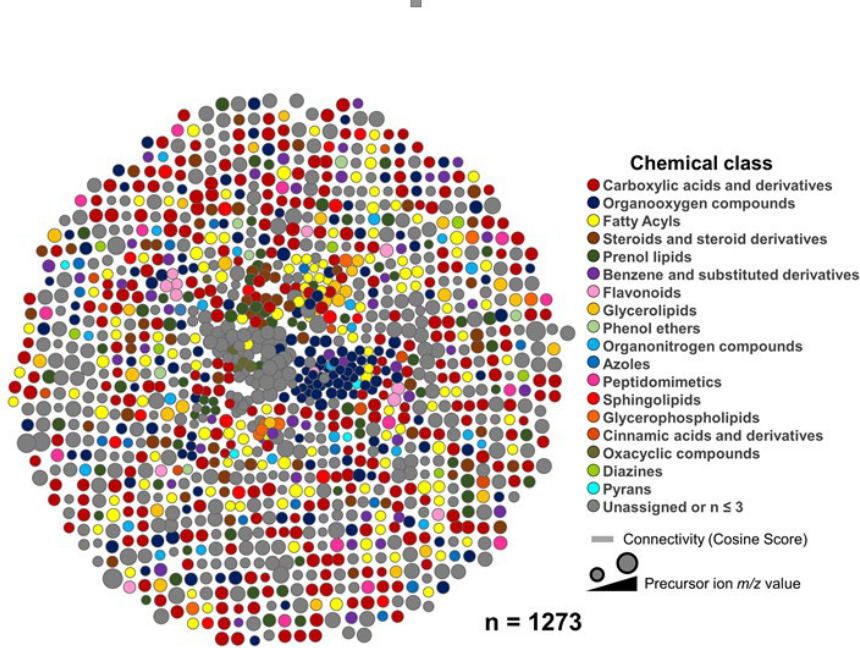
Figure 3. Eggplant metabolite molecular network. Chemical classes (Classyfire ontology, version 1.0 (http://classyfire.wishartlab.com, accessed on 10 August 2022) are assigned to the metabolites by the CANOPUS tool (implemented in SIRIUS Software version 4.9.12) and visualized by Cytoscape version 3.9.0 (https://cytoscape.org/, accessed on 10 August 2022). Each node represents a consensus or clustered MS2-containing feature, and the color node denotes the assigned chemical class. The m / z value of the feature is proportional to the node’s size.